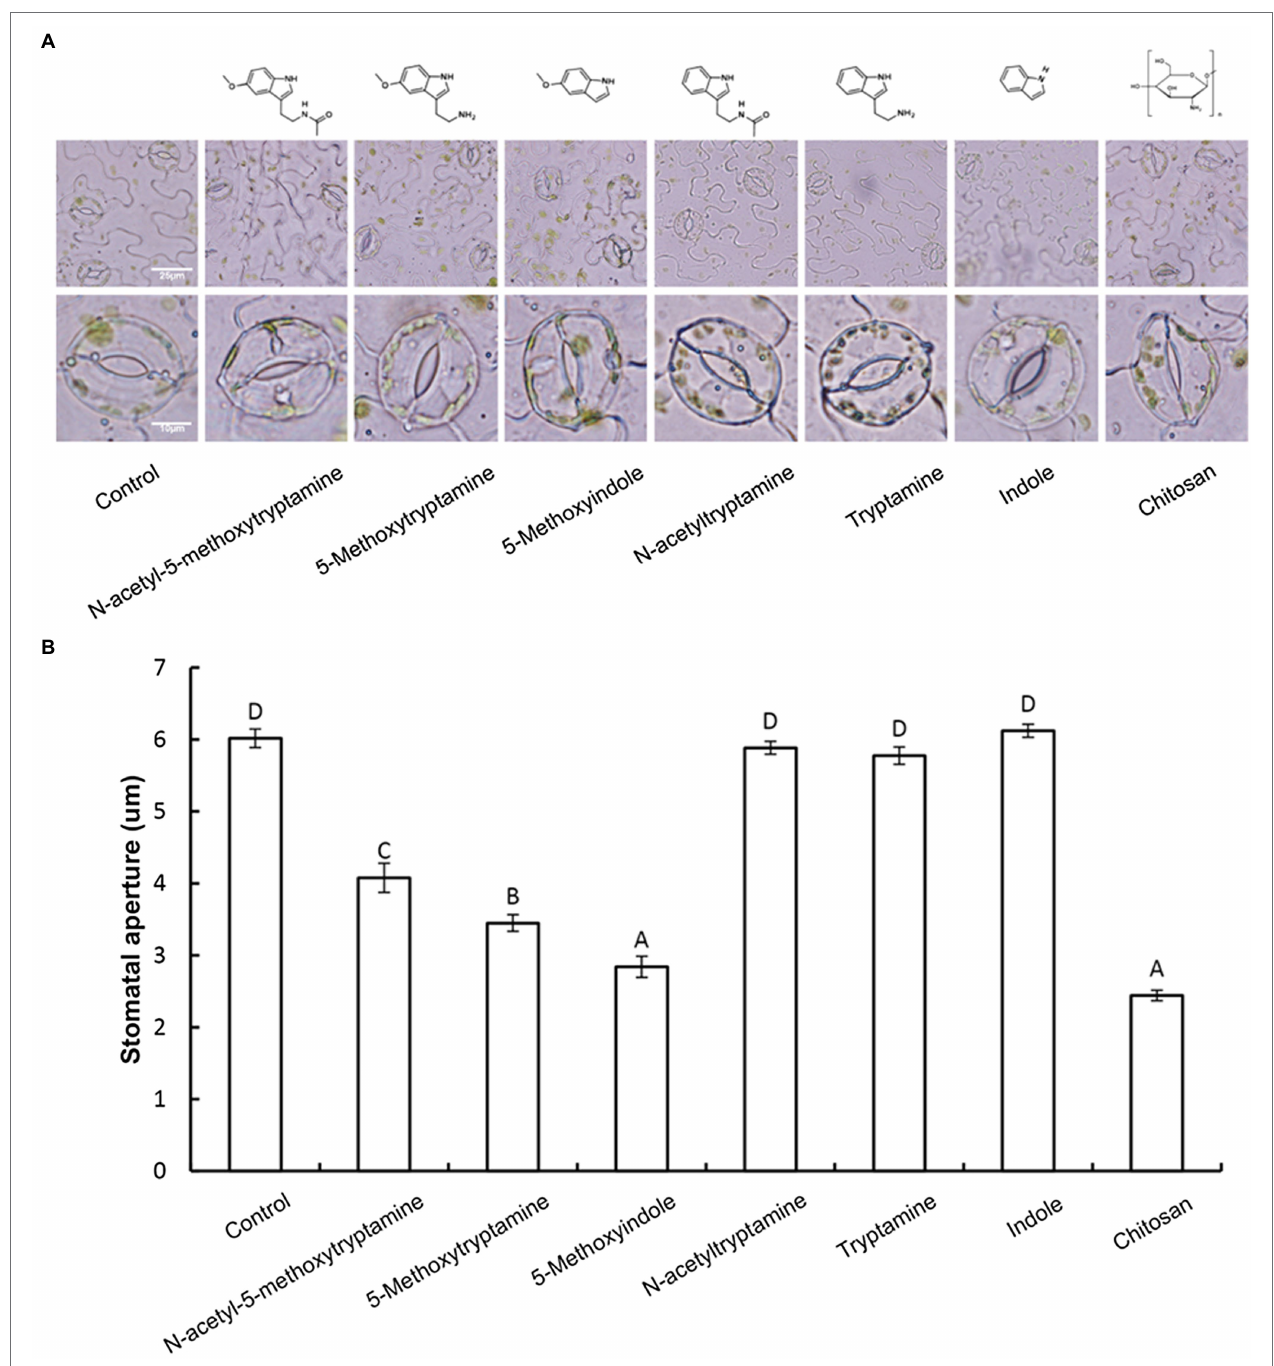
FIGURE 2 | Melatonin, 5-methoxytryptamin, and 5-methoxyindole induce stomatal closure in N. benthamiana leaves. Measurements of stomatal apertures in N. benthamiana leaves 3 h after plants were treated with a 50 μ M solution of MT, MT-homologs, and chitosan. Buffer-treated plants served as a control. 5-methoxytryptamin, 5-methoxyindole, and chitosan induced stomatal closure in N. benthamiana leaves, while the other test compounds and the buffer had no effect. (A) Representative micrographs of stomata in epidermal peels of treated plants 3 h after treatment with the test compounds. Lower panel of micrographs represents a higher magnification of individual stomata. (B) Stomatal data are the mean ± standard deviations (SDs; n = 150) of three independent experiments. Columns with different letters indicate significant differences in the aperture size of stomata of plants treated with the different test compounds as determined by a Duncan’s multiple range